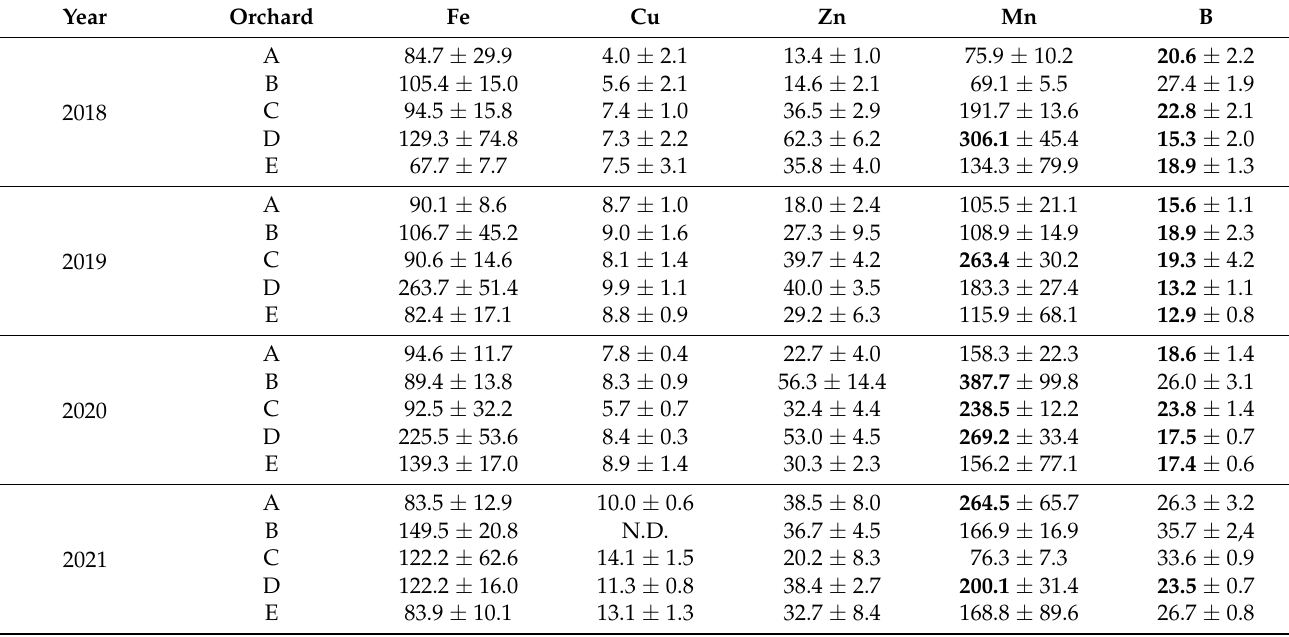
Table 7. Mean ± standard deviations of each micronutrient content (ppm) in leaves 90–110 DAFB ( n = 9). Values in bold indicate that the element concentration is outside the range between the minimum and maximum values for ‘Royal Gala’: Fe > 45; 10 < Zn < 100, 25 < Mn < 200, 25 < Bo < 50 and 10 < Cu < 50